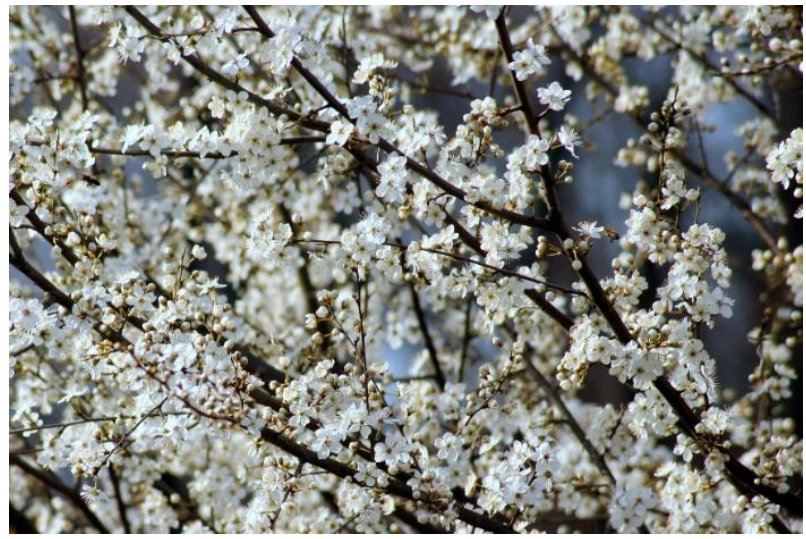
Figure 1. Representative Illustration of Plum Flowers.